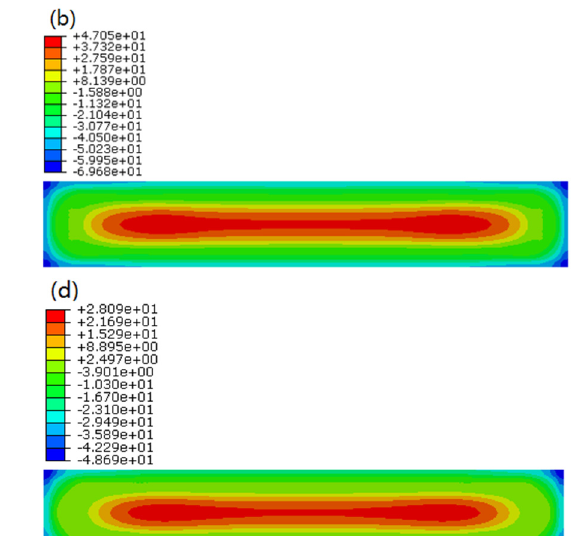
Figure 13. Measured cooling curves in AC, WQ (100 °C) and WQ (20 °C) ( a ) in the 1 mm deep (1#) ( b ) middle part (3#) of the sample by the lumped heat capacity method ( c ) sample of heat transfer coefficient experiment. The overall trend of temperature decrease was slow at first, then fast, and then slowed again. The calculation of the cooling rate was to take the approximate linear segment of 450–150 °C temperature difference (= 300 °C) and then divided it by the cor- responding cooling time under different cooling conditions, as shown in Table 1. Under the same cooling conditions, there is a temperature difference between the near-surface and the middle part because of the different cooling rates, which could be listed in the following orders: WQ (20 °C) > WQ (100 °C) > AC, so was the magnitude relationship of RS under these conditions.